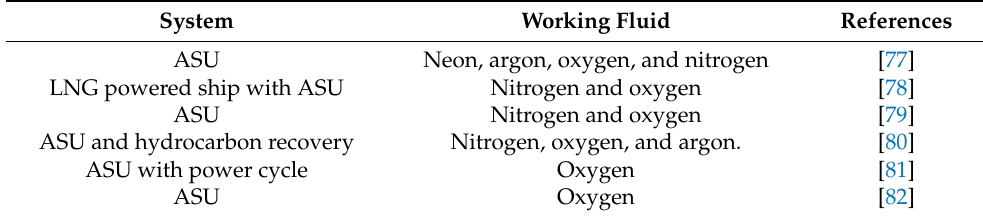
Table 3. Other works on standalone and integrated ASU